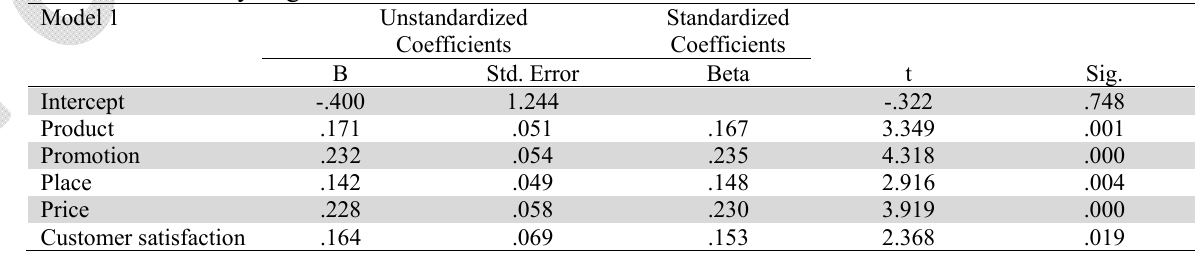
The results of analyzing the second model Model 1 Unstandardized